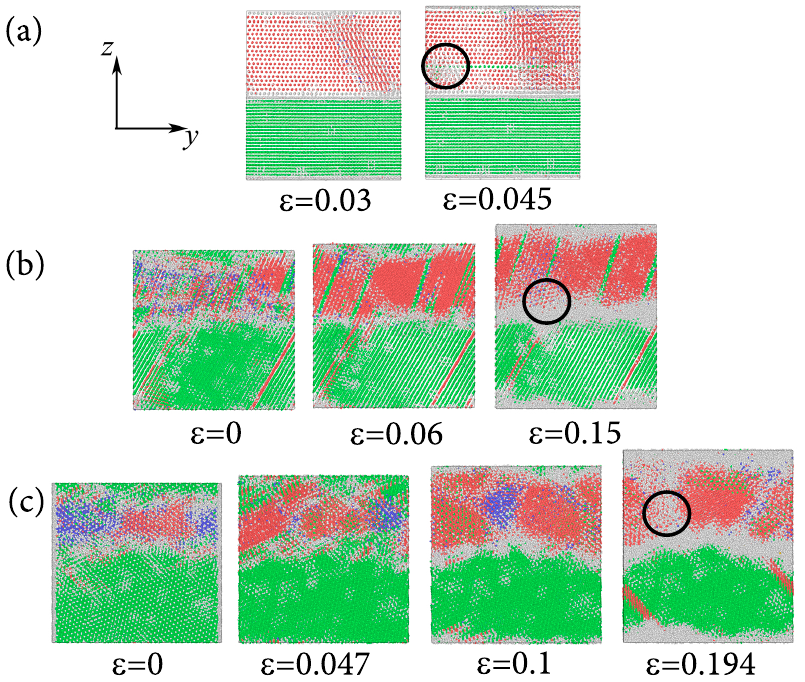
Figure 6. Snapshots of the structure in accordance with stress–strain curves shown in Figure 5: ( a ) tension of the initial sample; ( b ) tension of the sample after compression, stage I; ( c ) tension of the sample after compression, stage II. All atoms are colored by the CNA parameter, where HCP atoms are red, FCC atoms are green, BCC atoms are blue, and other atoms are